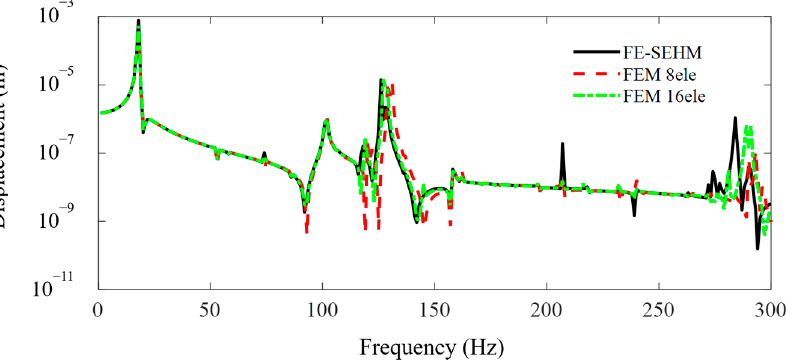
Figure 5. The FRF curves of the metamaterial plate at point B of the cover plate along the x axis obtained by the FEM and the